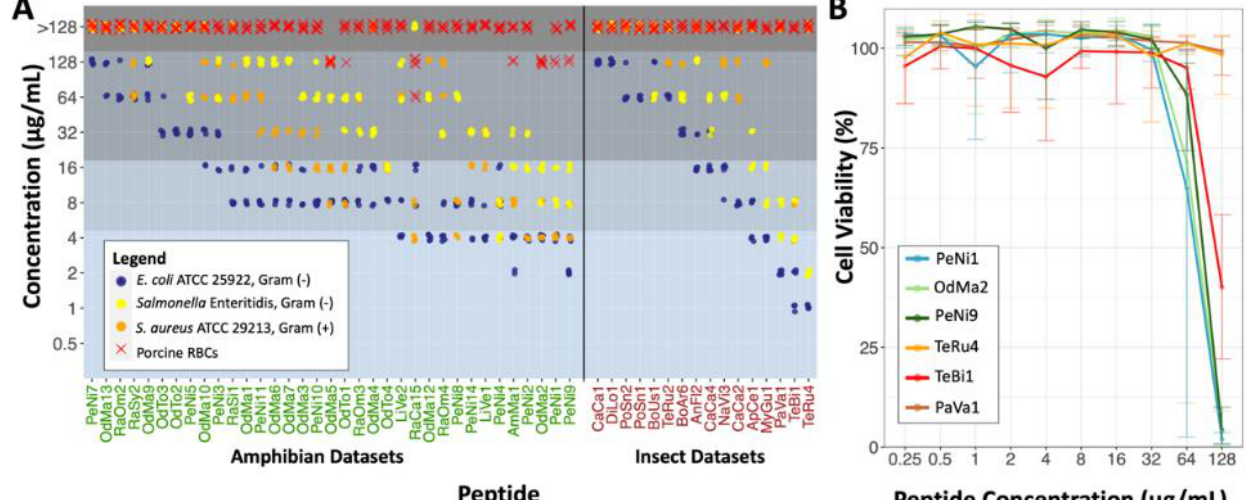
Figure 2. Antimicrobial activity and mammalian cell toxicity of peptides discovered. ( A ) Minimum inhibitory and hemolytic 50 concentration (MIC and HC50, respectively) of peptides with antimi- crobial activity against at least one bacterial strain within a panel composed of E. coli ATCC 25922, Salmonella Enteritidis and S. aureus ATCC 29213. HC50 was determined using porcine red blood cells (RBCs), as described in the Methods. Bioactive peptides identified from amphibian (green text) and insect (brown text) datasets are shown. Peptide bioactivity levels are separated by grey shaded blocks. From top to bottom, the dark grey block indicates no observable activity, the medium-dark grey block includes low activity, the medium grey block designates moderate activity, and the light grey block corresponds to high antimicrobial activity. ( B ) Mean relative cellular viability of HEK293 (cultured human kidney cells) after 24 h incubation with the six most active insect and amphibian peptides at concentrations up to 128 µg/mL from three independent experiments. Error bars indicate range of data.